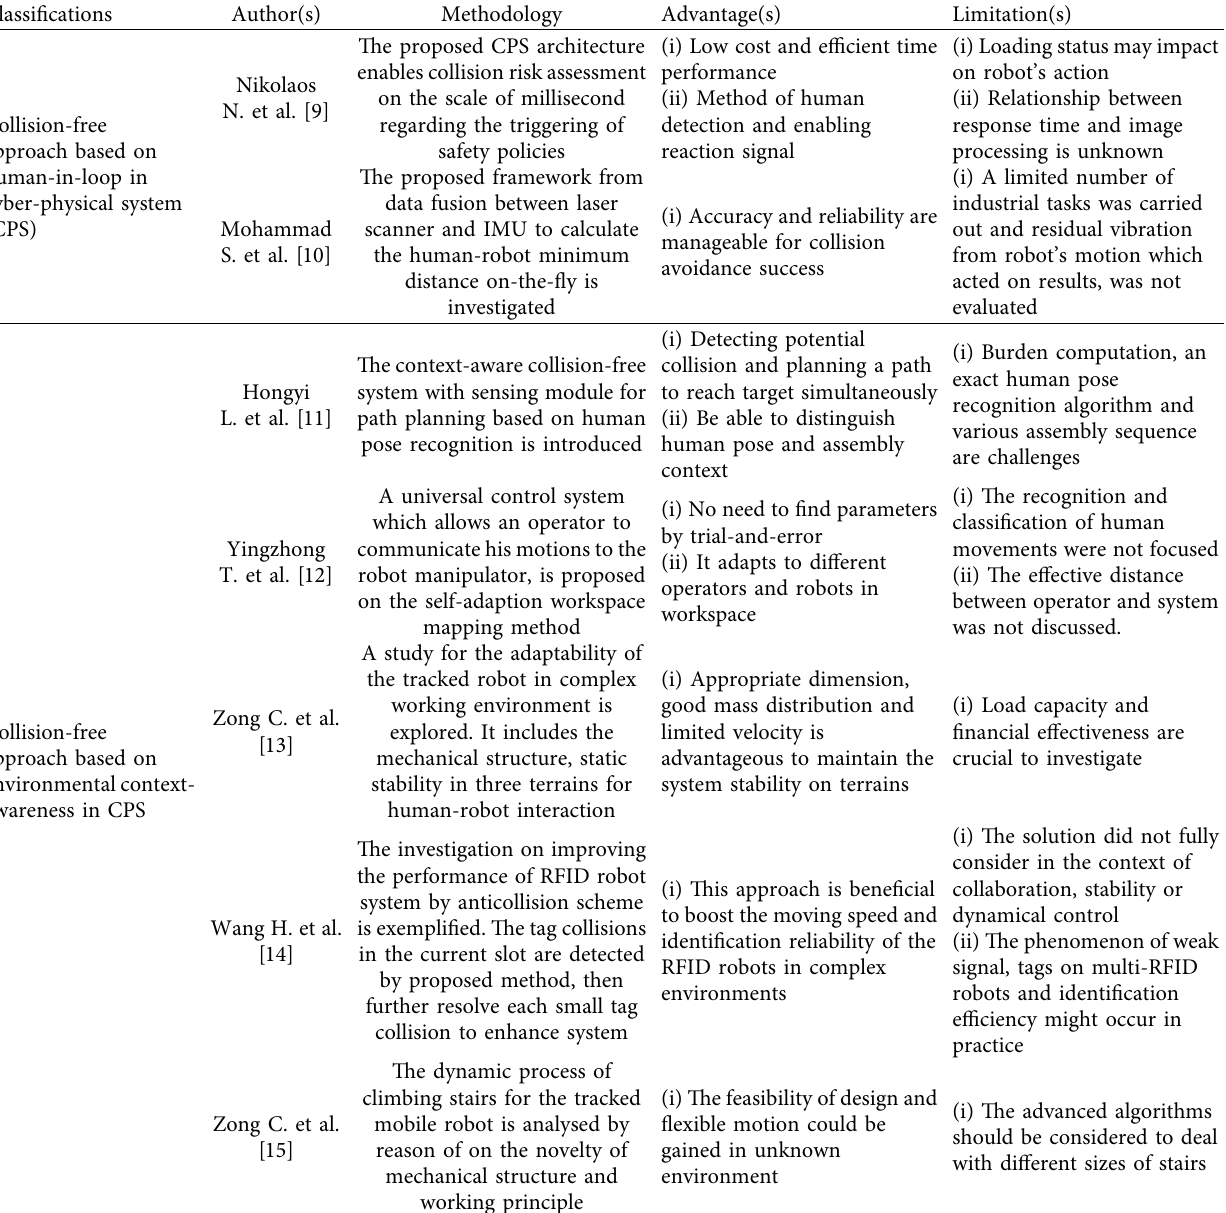
Table 1: The summary of the state-of-the-art research